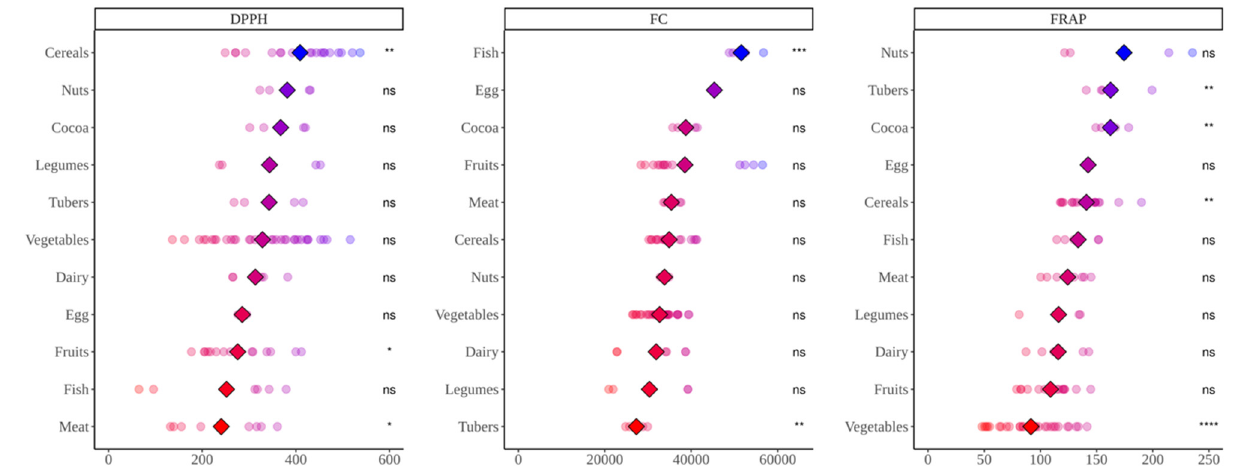
Figure 2. Antioxidant capacity of food obtained after in vitro fermentation of selected foods with fecal material from lean children. DPPH expressed as mmol Trolox equivalents/kg(L) of food; Folin–Ciocalteu (FC) expressed as mg equivalents of gallic acid/kg(L) of food; FRAP expressed as mmol Trolox equivalents/kg(L) of food. Diamonds represent the mean antioxidant capacity of each group. Dots represent the antioxidant capacity of each food within the group. Statistical analysis was performed via Kruskal–Wallis test. Each of the groups were compared to the average of all of them (i.e., base-mean). Statistic labels: *— p < 0.05, **— p < 0.01, ***— p < 0.001, ****— p < 0.0001, ns—not significant.